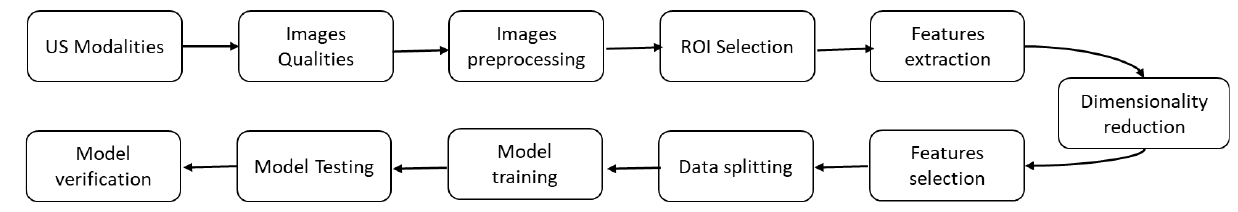
Figure 7. Methodology used to design models.